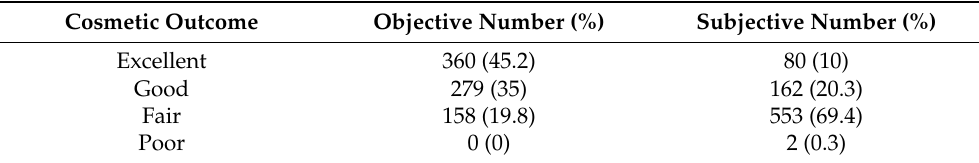
Table 6. Objective and subjective cosmetic outcome after Intra-Operative Electron Radiation Therapy and Whole Breast Irradiation (IOERT + WBI) according to the Harvard scale.